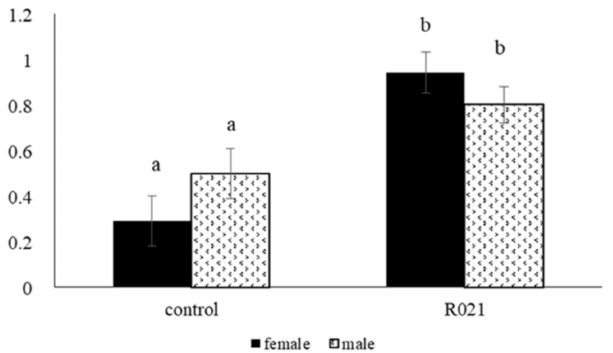
Figure 4. HOMAR IR index in female and male fetuses on Day 28 of gestation of ad libitum (Control group) and fed restricted females (105 g/day) during the first two-thirds of gestation and re-fed ad libitum until term (R021 group). Day 0, day of artificial insemination (AI); length gestation, 31 days. Different letters indicate significant differences between groups ( p < 0.05). HOMA index: [insulin (mU/L) × (glucose